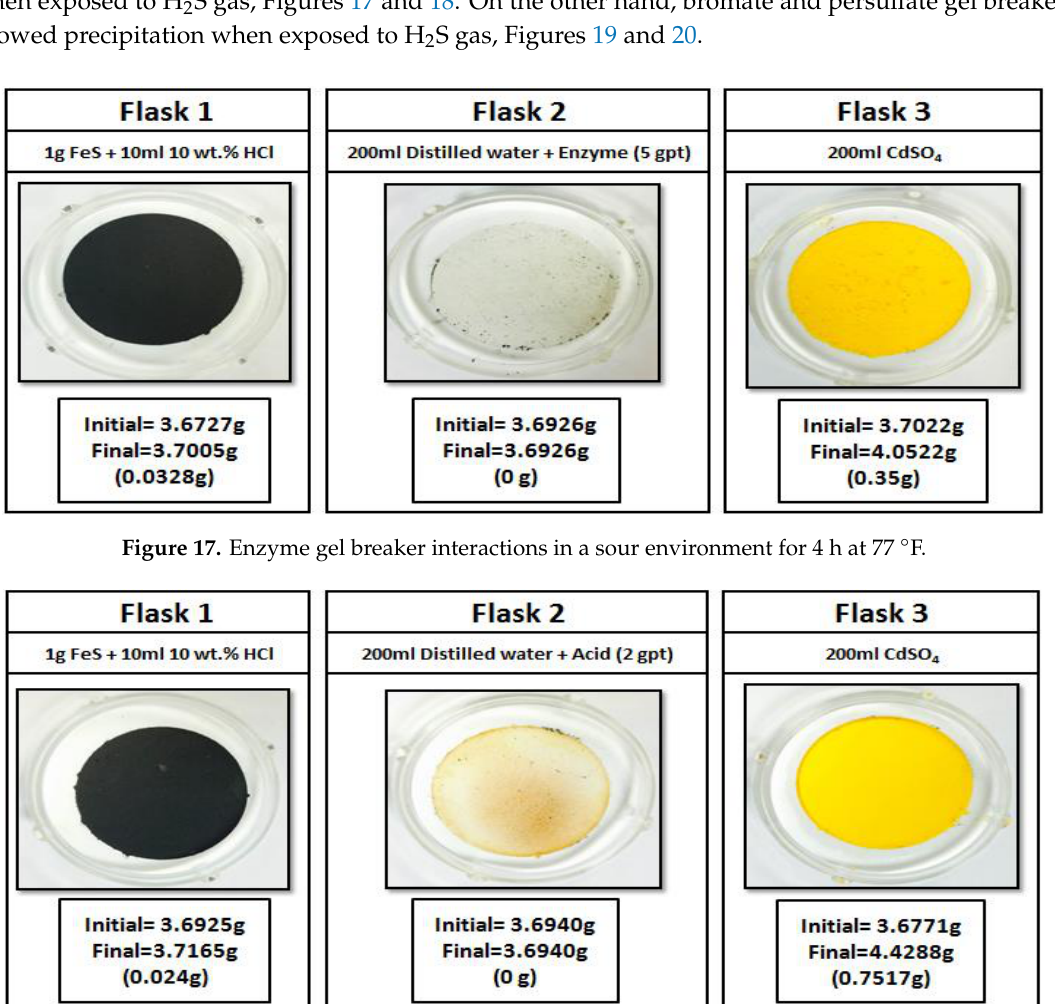
16 of 23 Figure 16. GPC results of polymeric clay stabilizer 2 exposed to different gel breakers (persulfate: 8 ppt, bromate: 8 ppt, acid: 2 gpt, enzyme: 5 gpt) after 24 h at 200–300 °F. Table 5. Peak molecular weight values of polymeric clay stabilizer 2 with gel breaker samples after 24 h. Samples